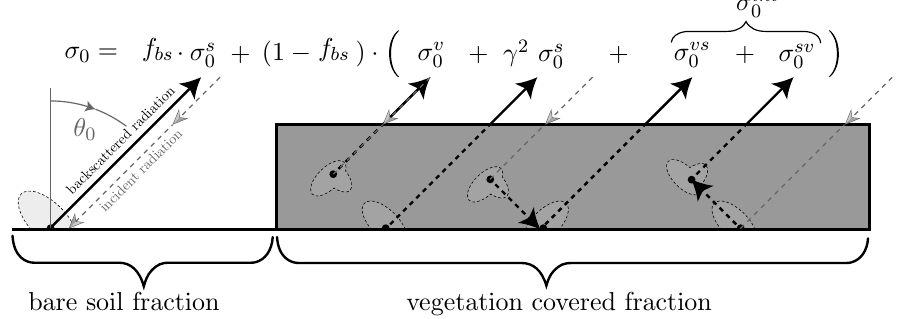
Figure 1. Contributions to the backscattered